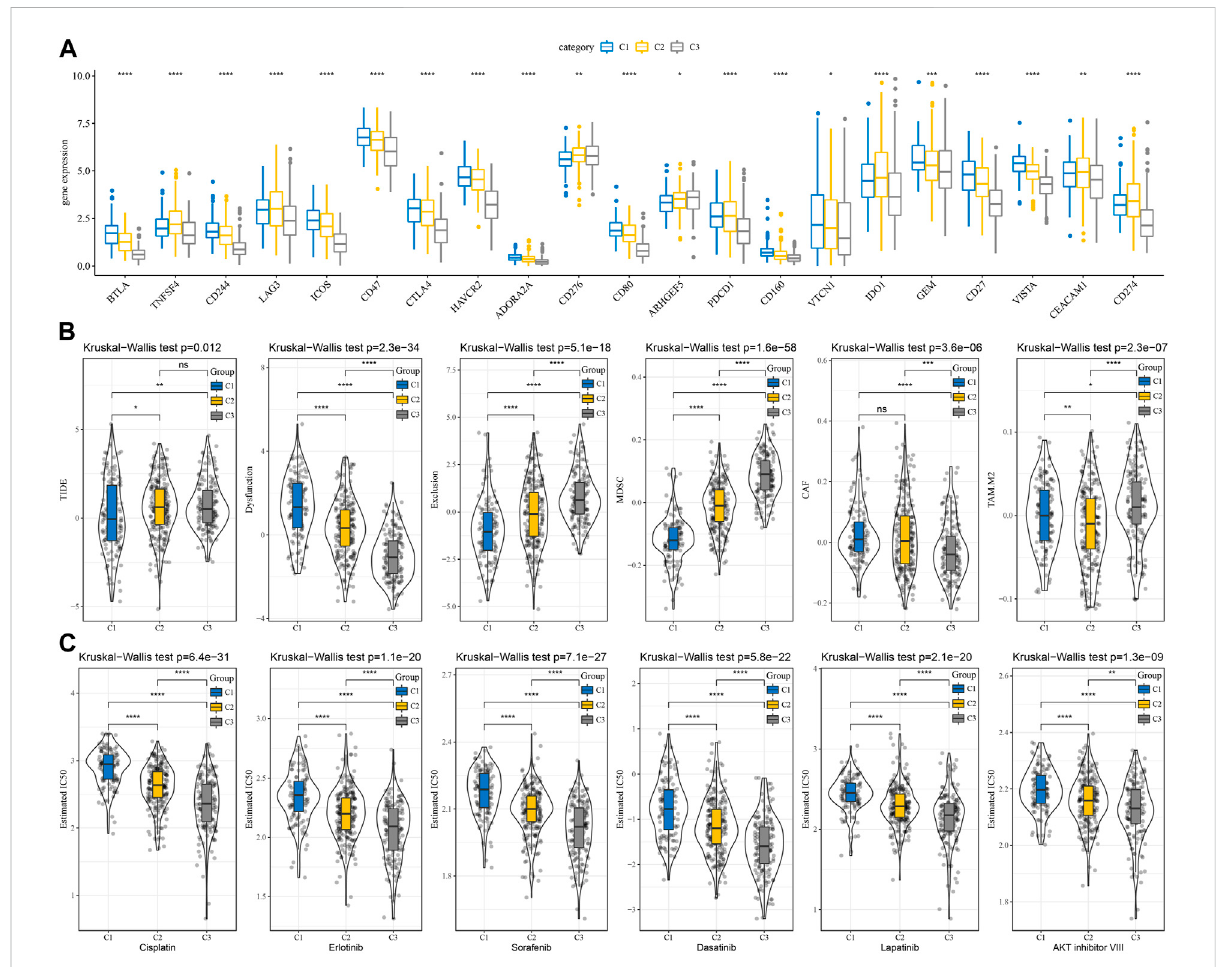
FIGURE 4 Differences in immunotherapy and chemotherapy scores between subtypes. (A) Immune checkpoints differentially expressed between subtypes in the TCGA cohort; (B) Differences in TIDE analysis results between subtypes in the TCGA cohort; (C) The box plots of the estimated IC50 for Cisplatin, Erlotinib, Sorafenib, Dasatinib, Lapatinib, and AKT inhibitor VIII in TCGA cohort. * p < 0.05, ** p < 0.01, *** p < 0.001, **** p <